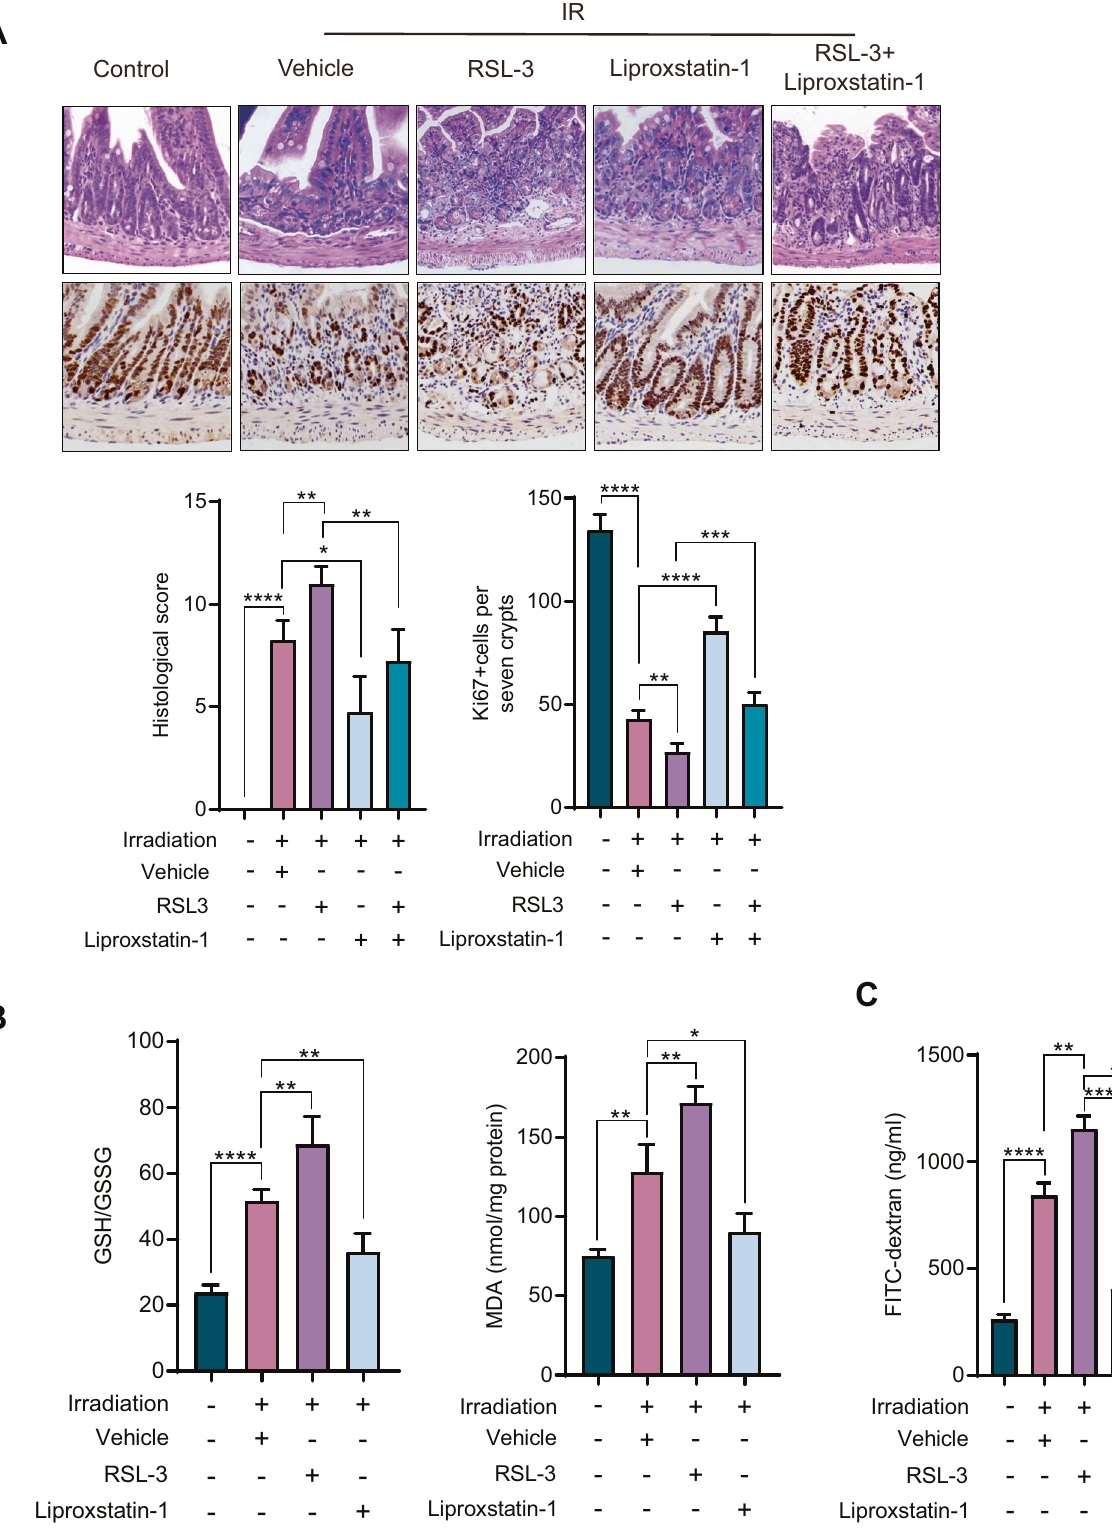
Fig. 3 Ferroptosis promotes radiation injury in mice. A Histological scores of intestinal tissues of mice after IR. Ki67 + cells were counted in seven crypts. Representative images of the H&E staining and Ki67 staining of the intestine from control, vehicle, RSL-3, Liproxstatin-1, and RSL- 3 + Liproxstatin-1 groups. B Analysis of GSH/GSSG and MDA in intestinal control, vehicle, RSL-3, Liproxstatin-1, and RSL-3 + Liproxstatin-1 of mice. C Analysis of intestinal permeability of mice in control, vehicle, RSL-3, liproxstatin-1, and RSL-3 + Liproxstatin-1 treatment groups to FITC- Dextran. P values are derived from permutation test, two-sided Student ’ s t test. * p < 0.05, ** p < 0.01, *** p < 0.001, **** p <